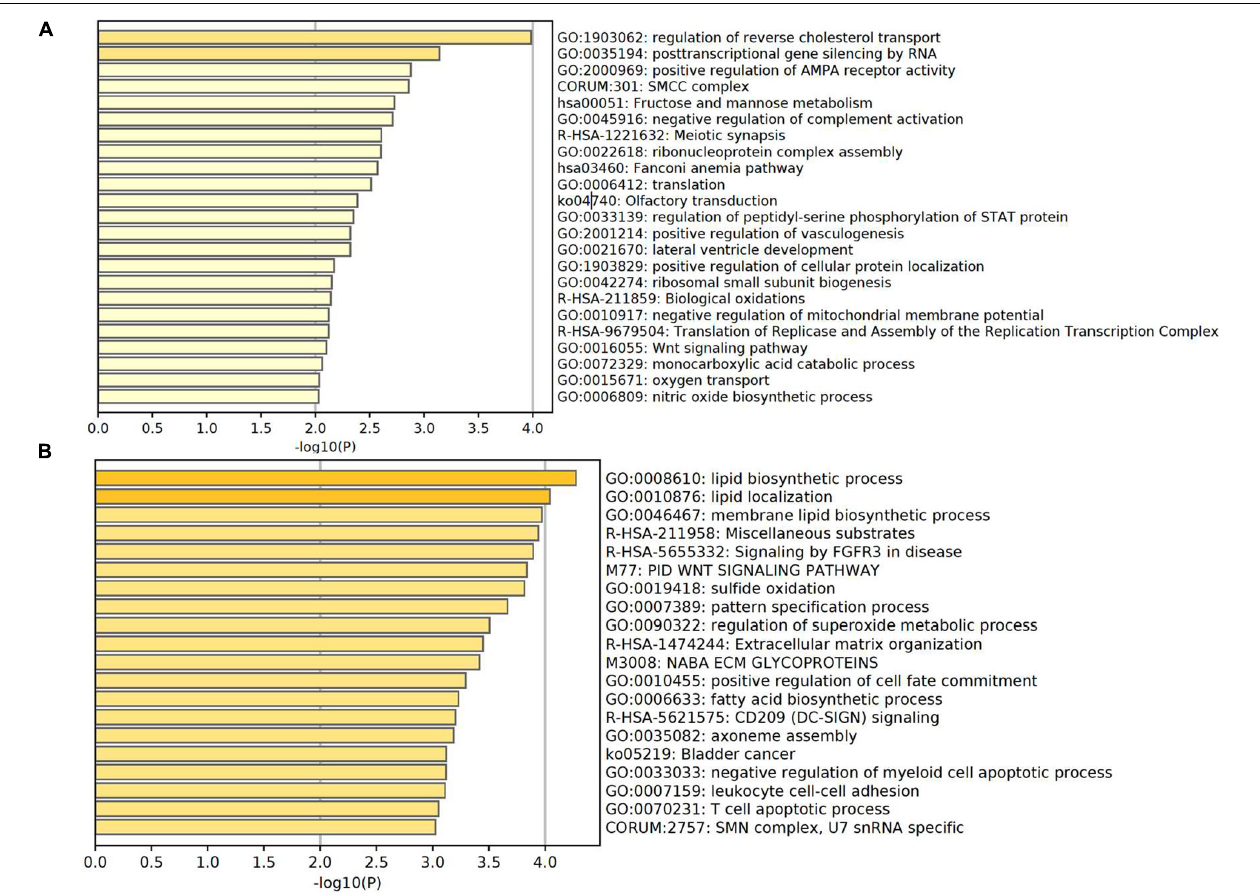
FIGURE 4 | Enriched pathways of genes with significantly higher in panel (A) and lower in panel (B) coverage of TSS region in severe patient compared with mild